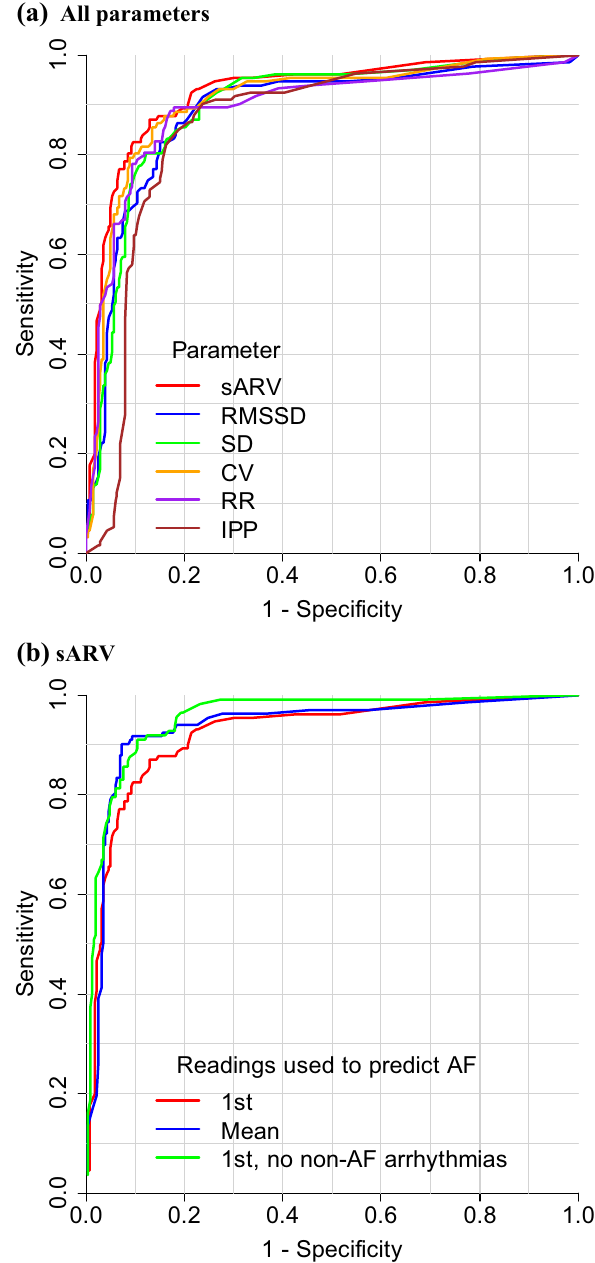
Figure 1. Receiver operating characteristics curves for AF detection from pulse rate variability by: ( a ) all parameters and, ( b ) sARV. 1st 1st reading, CV coefficient of variation, IPP irregular pulse percentage, RMSSD root mean square of successive differences, RR relative range, sARV standardised average real variability, SD standard